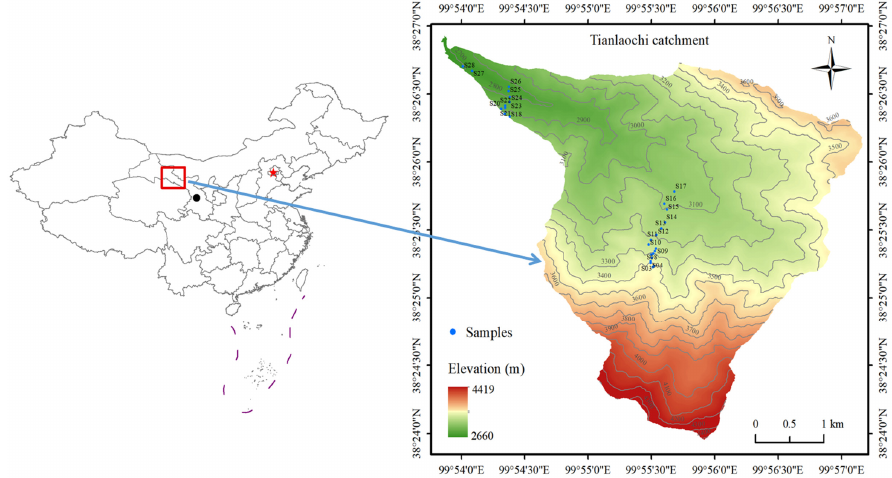
Figure 1. Sampling sites in the SDL from the Qilian Mountains, Gansu province, China.